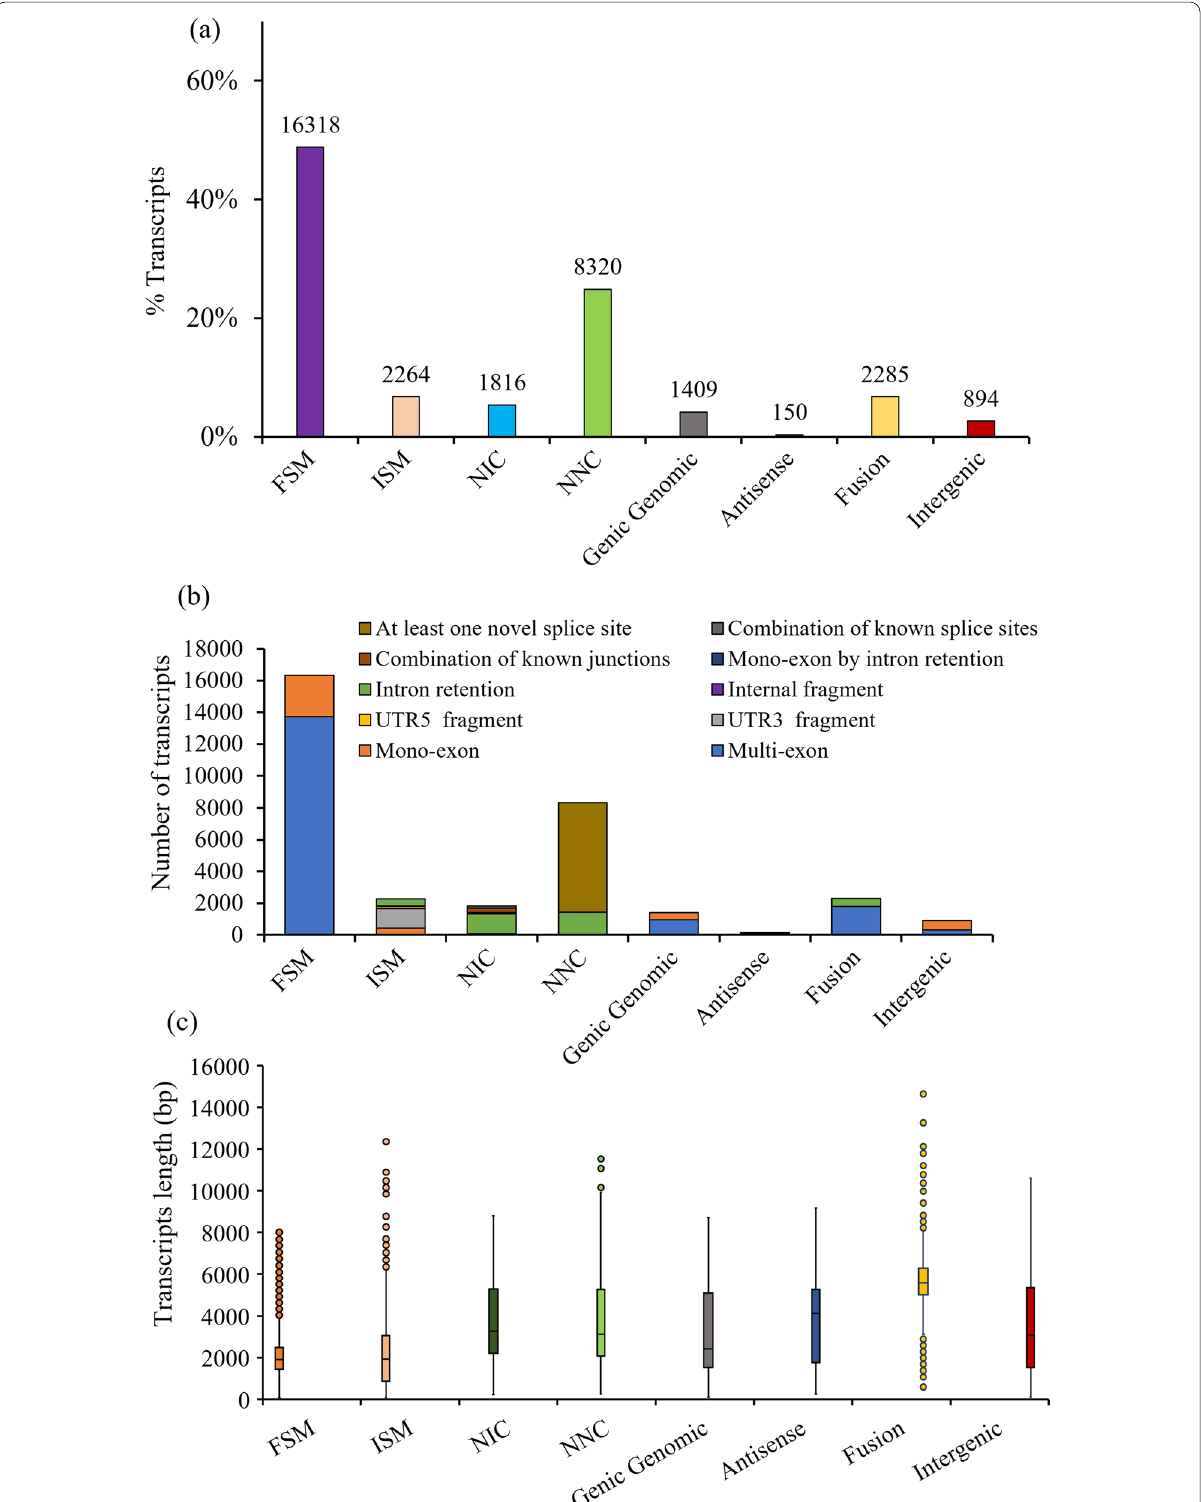
Fig. 2 Characterization of isoform categories of PacBio transcriptome: a percentage of the PacBio transcriptome in different isoform categories ( FSM full splice match, ISM incomplete splice match; NIC Novel In Catalog, NNC Novel Not in Catalog, Genic Genomic, Antisense, Fusion, and Intergenic); b structure of different categories of isoforms c length of PacBio transcripts by different isoform